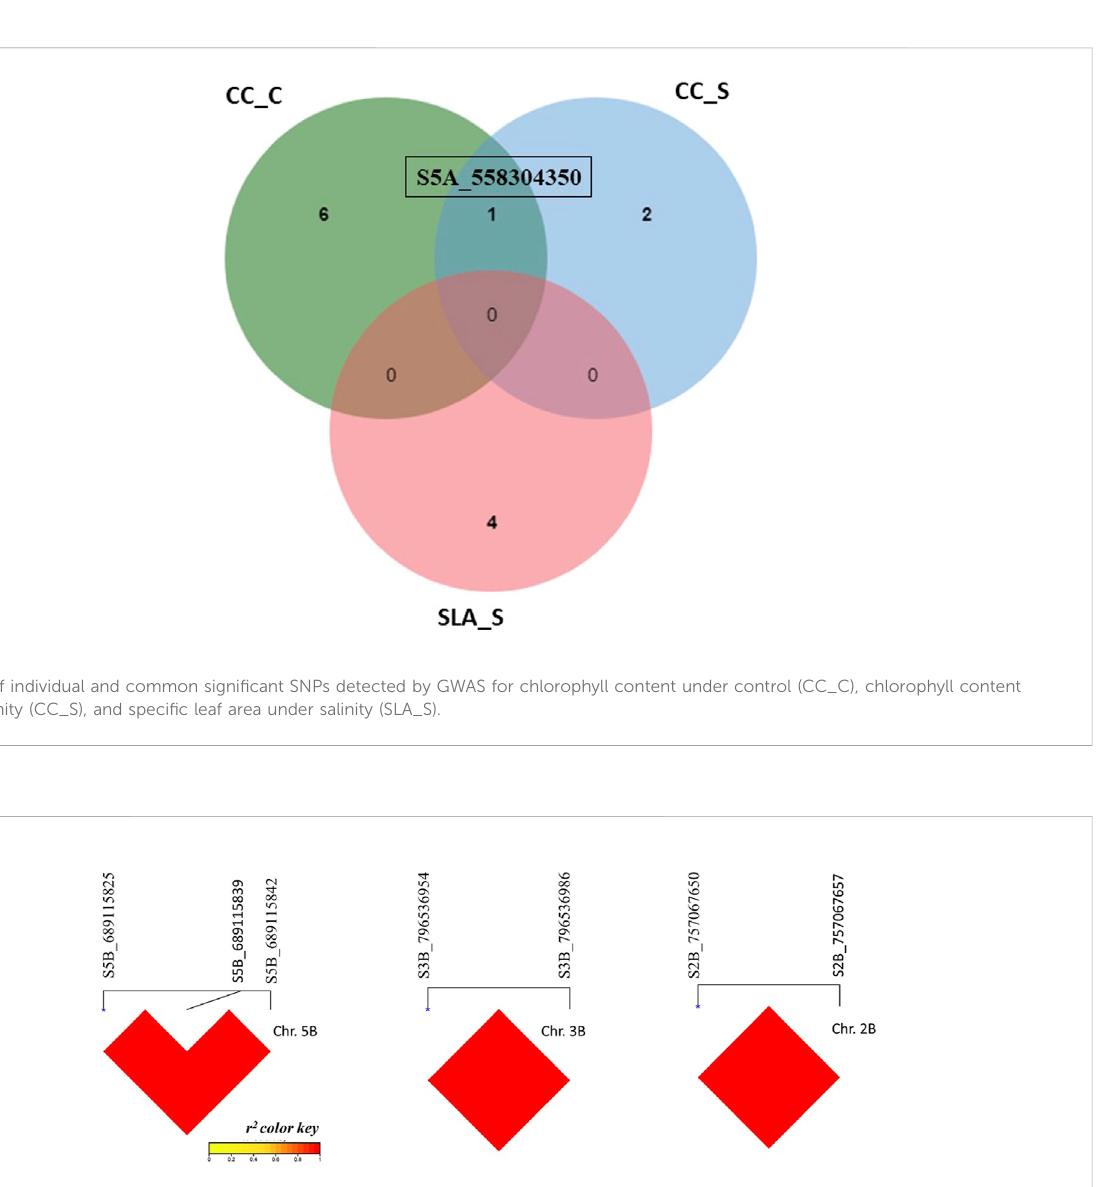
FIGURE 6 I,inkage disequilibrium r2 among signi fi cant SNPs located on the same chromosome. Red refers to complete 1.1)